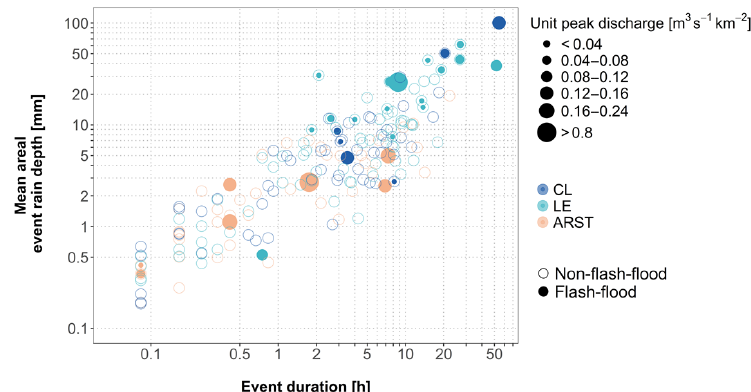
Figure 9. Scatter plot of rain events’ mean areal rain depth over the catchments vs. duration, for flash-flood-associated (filled circles) and non-flash-flood events (empty circles), with respect to different synoptic types and different unit peak discharges of the flash-flood-related events. In case of flow in both catchments, maximum unit peak discharge is presented. Over 90% of the watershed area is covered by rainfall during flash-flood-related events (79% for the non-flash-flood-related events). Event duration refers to the part of the event where rain cells were found over the